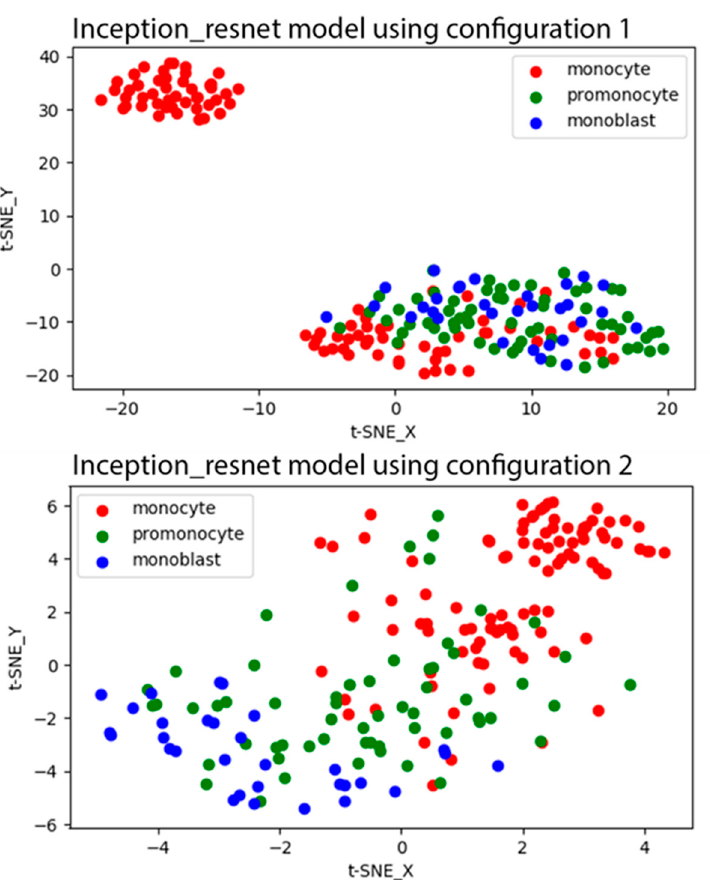
Figure 2. t-SNE plots for the performance of the Inception_resnet model using configurations 1 and 2 on the test. In the configuration 1 plot, all promonocytes demonstrated similar features to blasts and some of monocytes were also not discernable from blasts. In the configuration 2 plot, promonocytes were distributed across monocyte and blast classes. Table 3. Overall performance of fivefold cross validation using the Inception_resnet CNN model. 5-Fold Cross